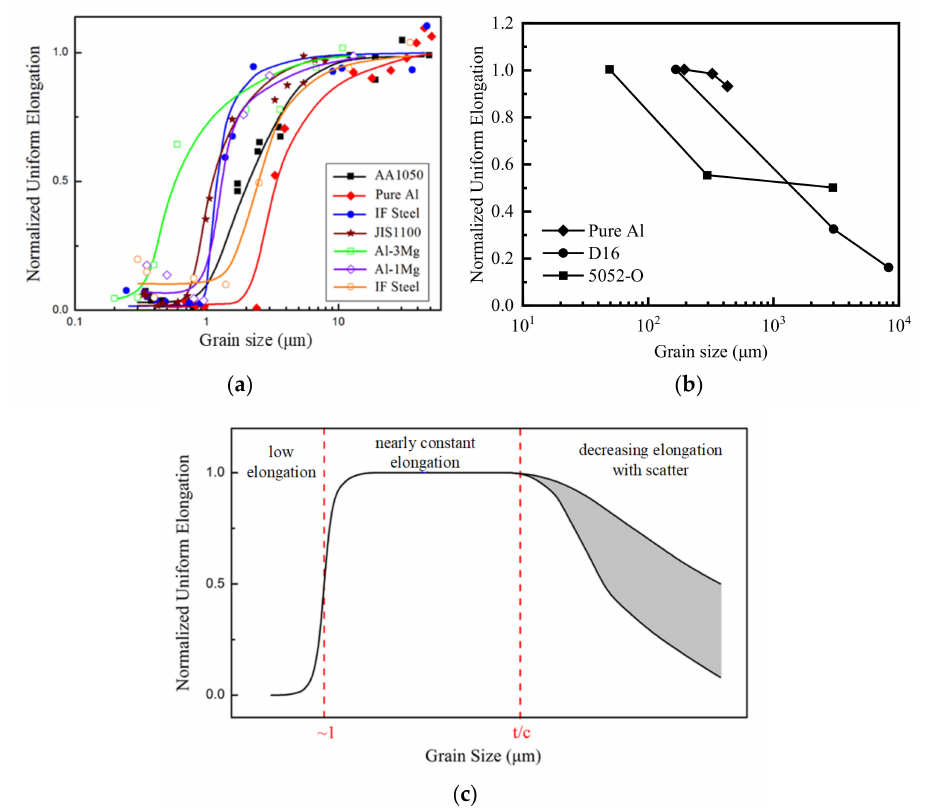
Figure 14. Grain size dependence of uniform elongation in ( a ) ultrafine and medium grain size range ( < 100 µ m); ( b ) coarse grain range ( > 100 µ m, redrawn from source reference) and ( c ) schematic illustration for grain size-dependent uniform elongation, where t indicates the specimen thickness, and c is a constant with a value of about 4–5 (Reproduced with permission from Springer Nature